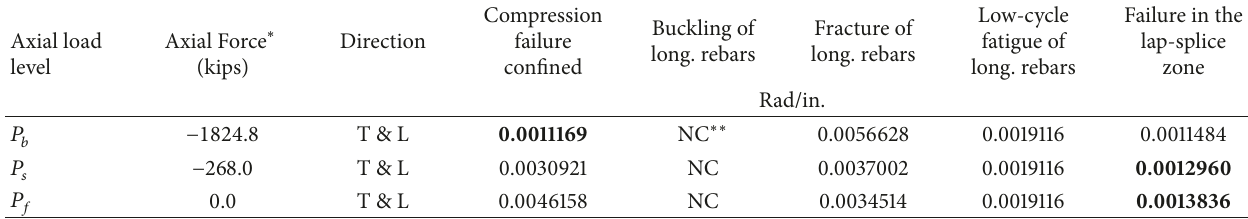
Table 14: Plastic curvature capacity of new columns, Pier #2 & #3 of Bridge #4-W.